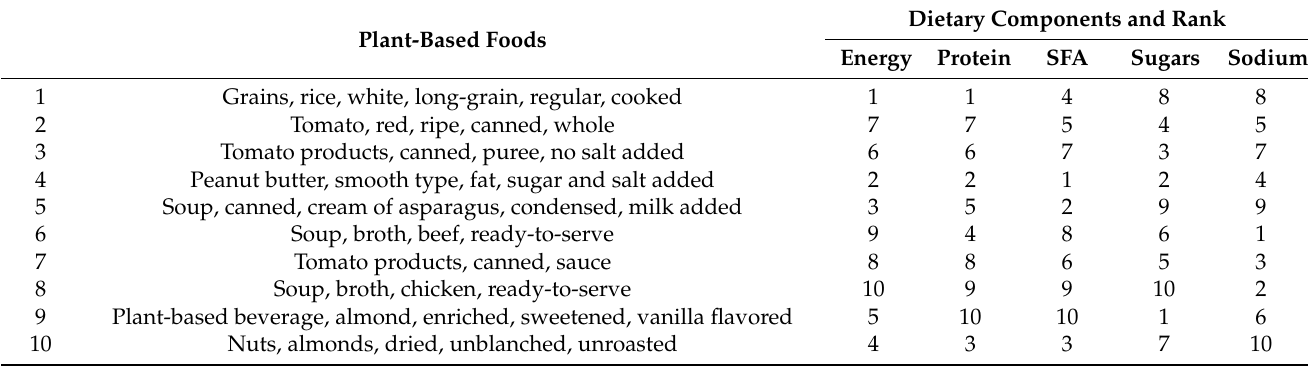
Table 3. Ranking of the top 10 most frequently reported plant-based foods based on their contri- bution to nutrients-to-limit, energy, and protein intake ( n = 20,176), 2015 Canadian Community Health Survey. Plant-Based